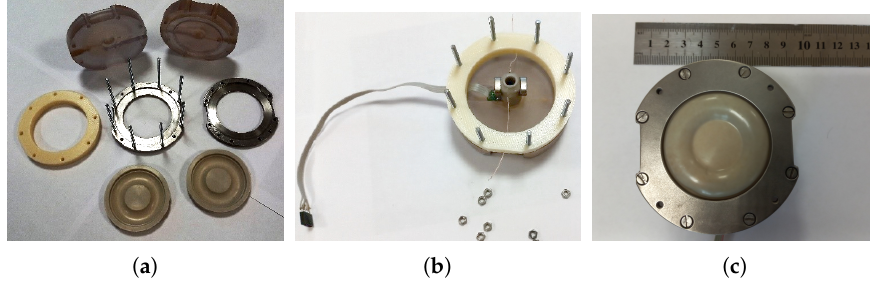
Figure 2. Photo of the MHD/MET system. ( a , b ) during and ( c ) after assembling.